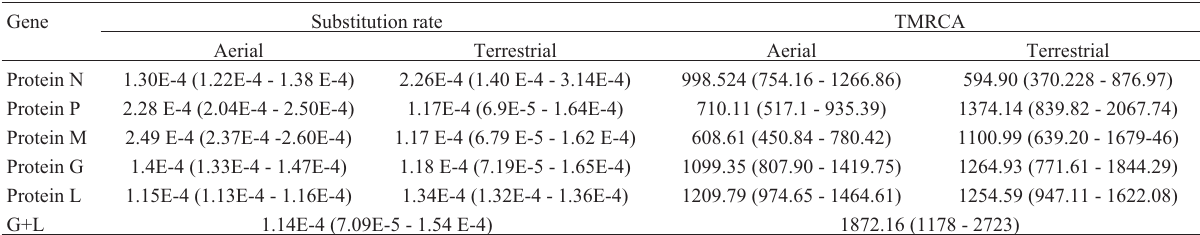
Table 4 - Nucleotide substitution rates per site and TMRCA for the N, P, M, G and L genes separately in the aerial and terrestrial cycles and for both cy- cles together using the G and L genes concatenated.